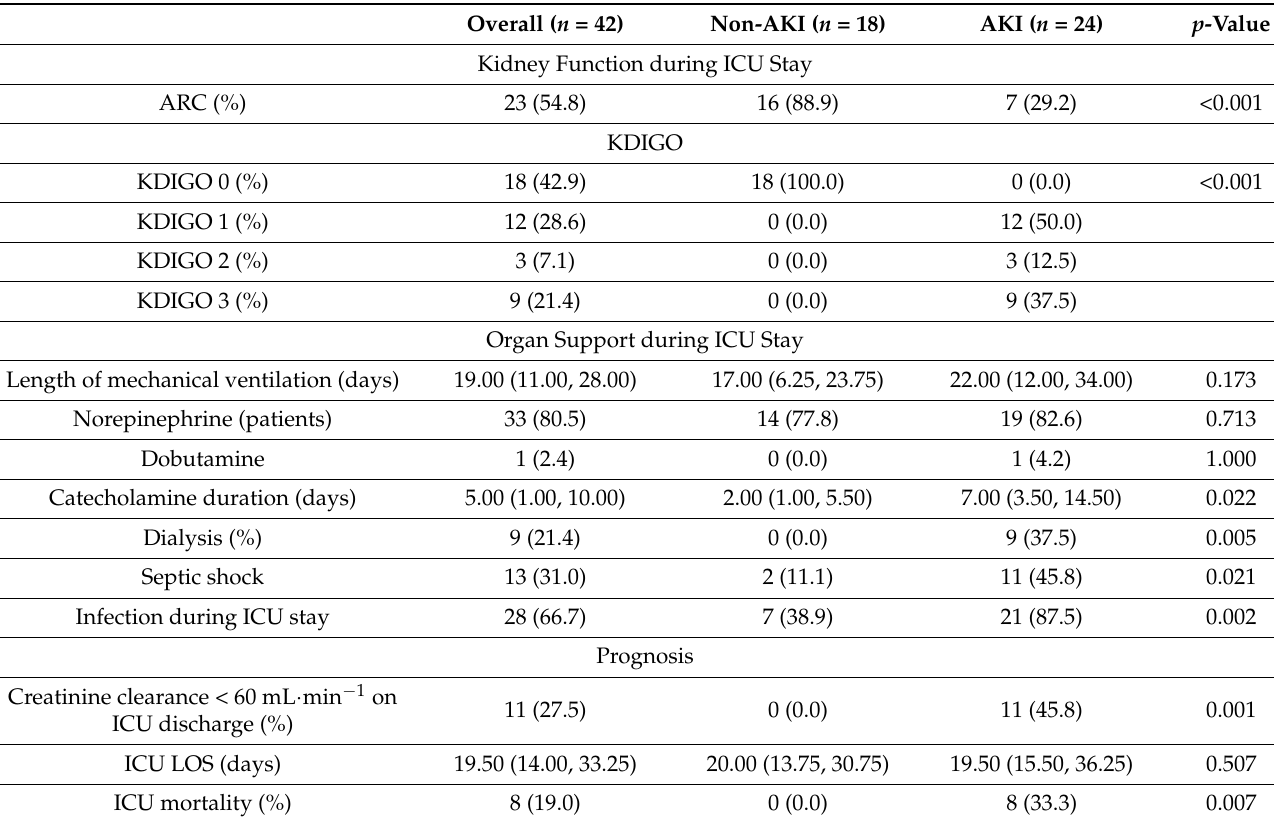
Table 4. Prognosis of severe acute respiratory syndrome coronavirus 2 (SARS-CoV-2) patients according to the presence of an acute kidney injury during the ICU stay.